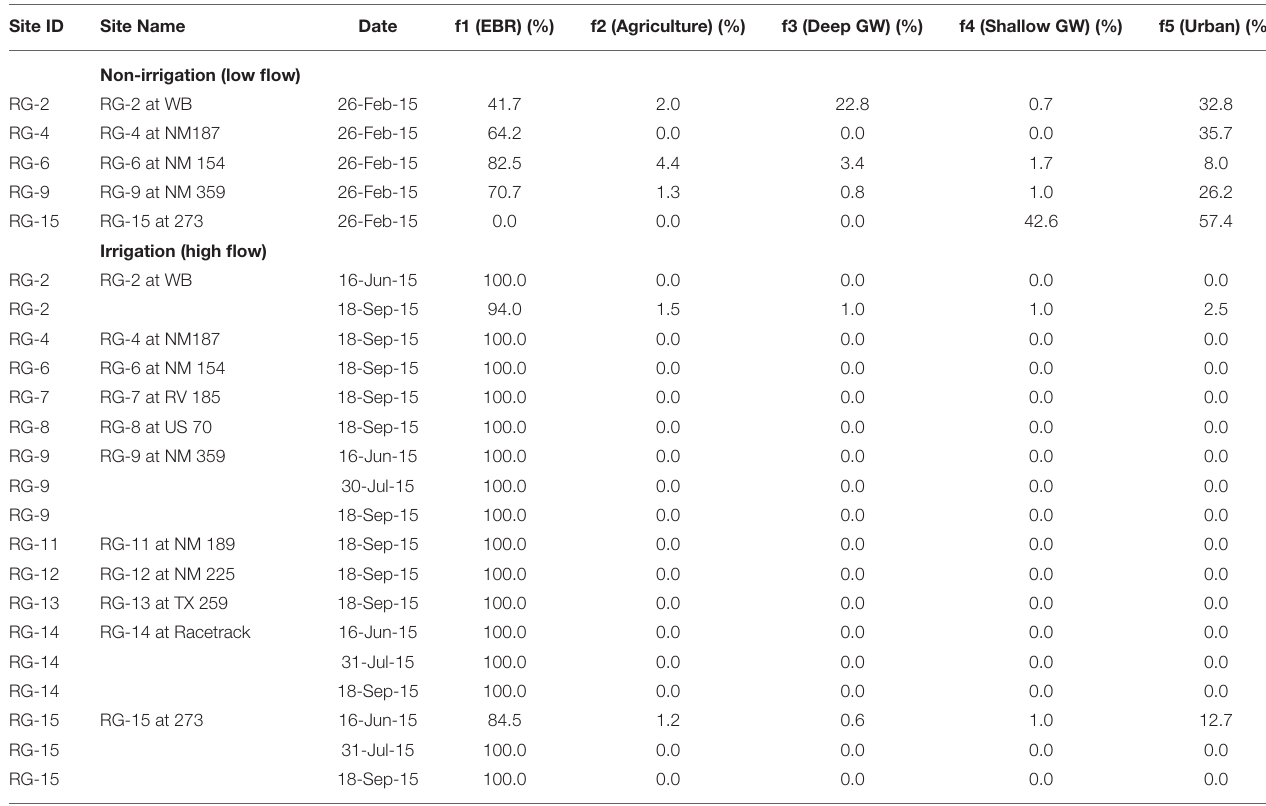
TABLE 2 | Relative water mass contributions (%) to Rio Grande for selected locations for non-irrigation and irrigation seasons. Site